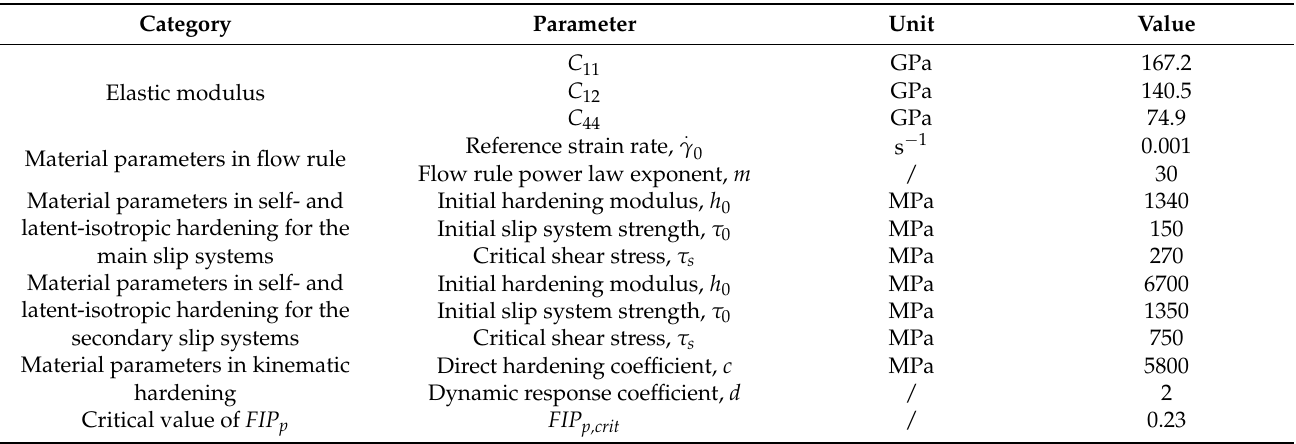
Table 1. Parameters of X12CrMoWVNbN10-1-1 related to crystal plasticity